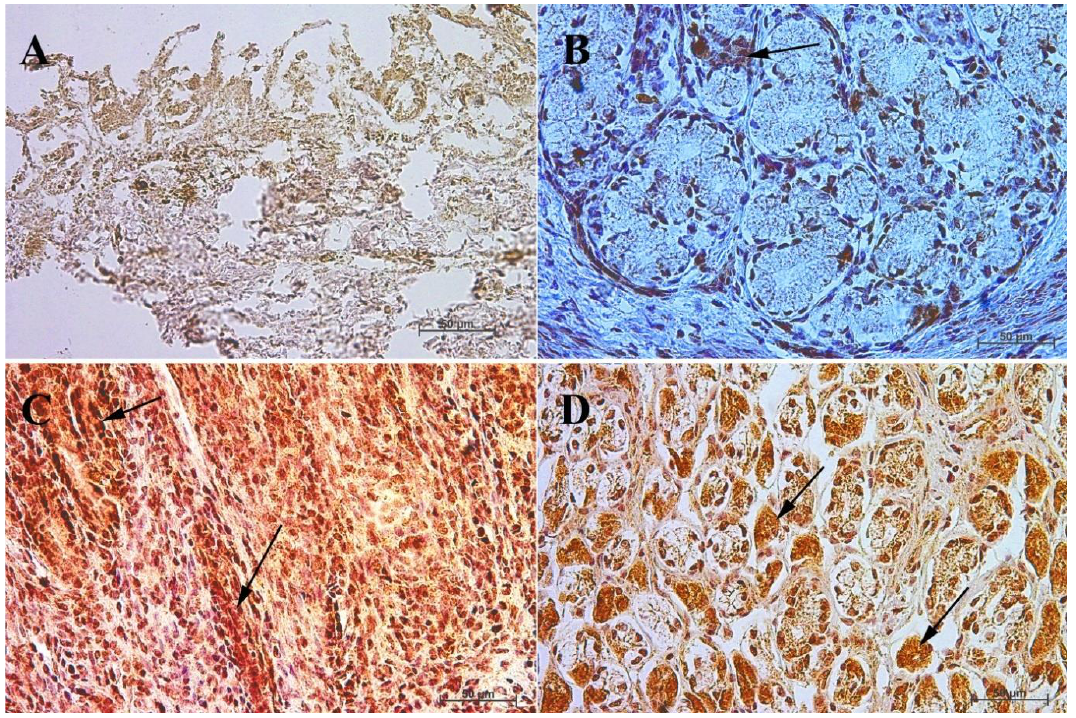
Figure 3. Immunoreactivity of anti-gastrin antibody in the fundic mucosa of the stomach, 40×. ( A ) the first age group, ( B ) the second age group, ( C ) the third age group, ( D ) adult reference group. The arrow indicates positive immunohistochemical reaction.